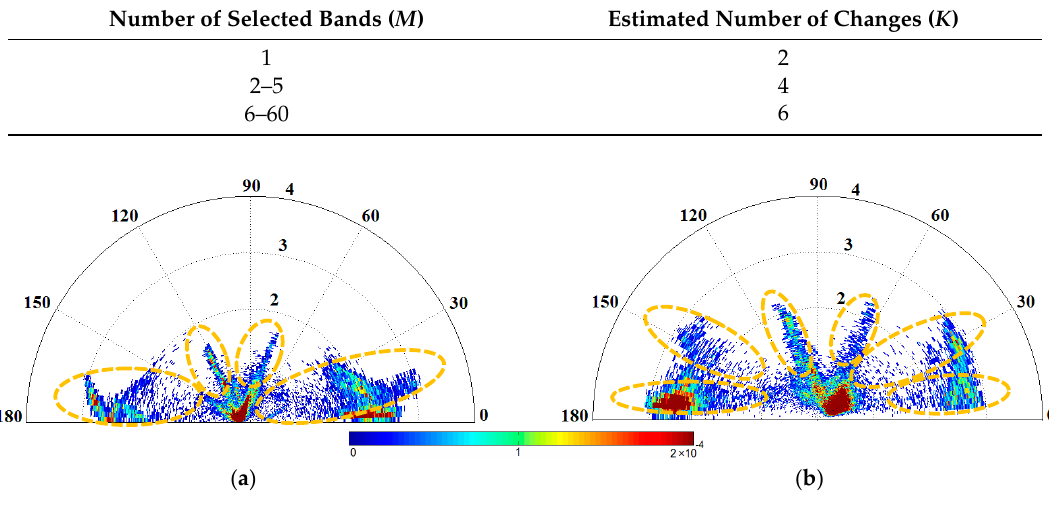
Figure 13. S 2 CVA 2D change representations obtained on X S when: ( a ) M = 2 (four changes were identified); ( b ) M = 10 (six changes were identified).